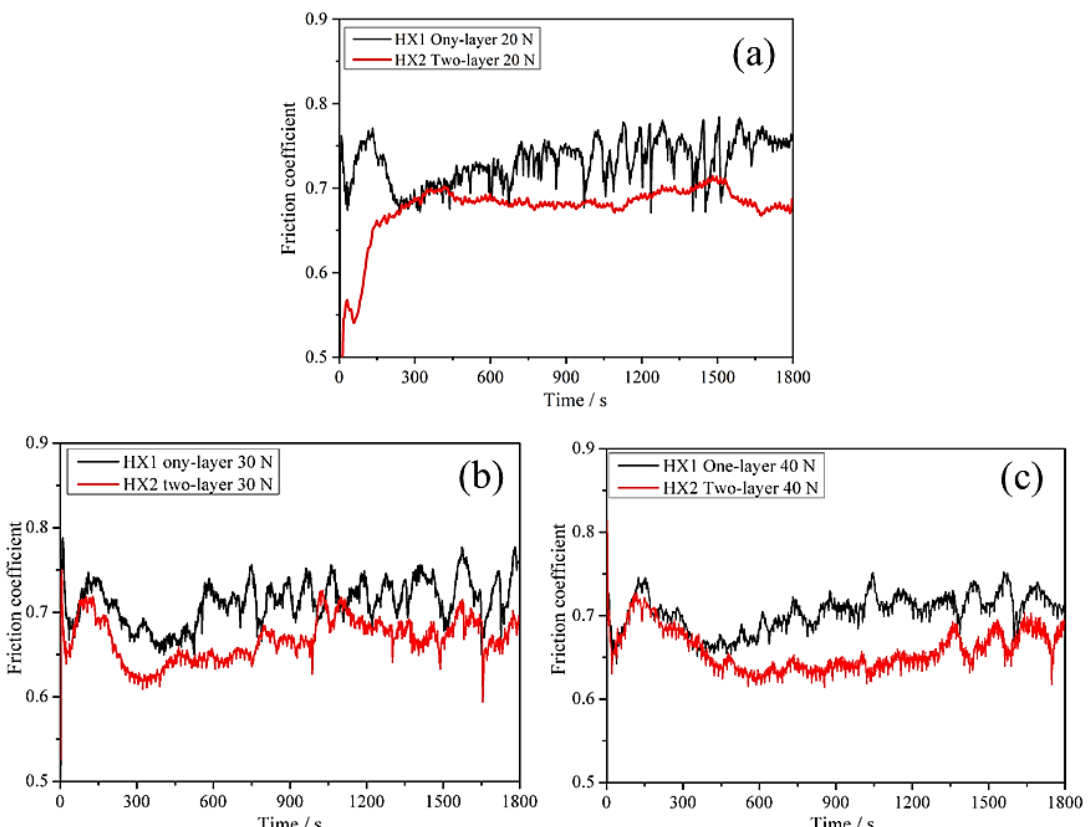
Figure 6. The change of friction coefficient of the HX1 and HX2 coatings as a function of time under different loads. 20 N ( a ), 30 N ( b ), 40 N ( c ).